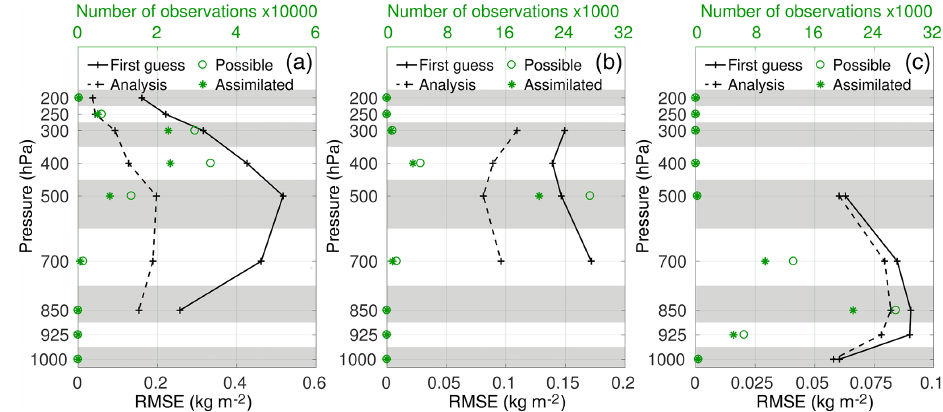
Figure 3. Vertical profiles of the RMSE per bins of CEP for the three phases IWP (a) , SWP (b) , and LWP (c) for the ensemble mean first guess (solid lines) and analysis (dashed lines) as a mean over all periods listed in Table 1. The number of possible (circles) and assimilated (asterisks) observations is shown in